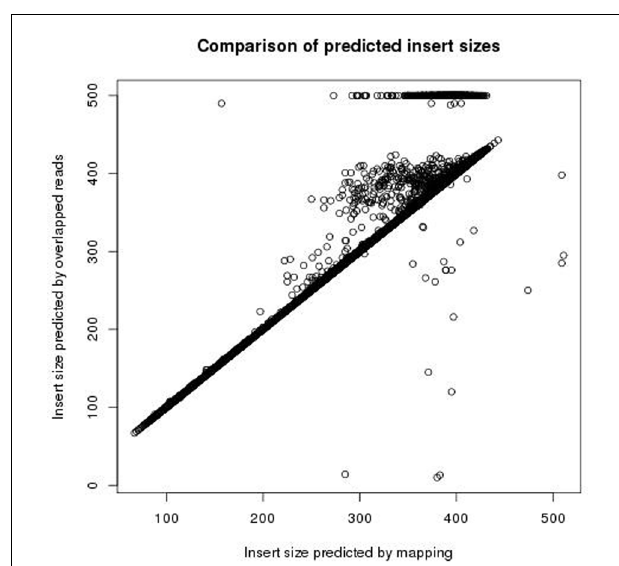
FIGURE 6 | Plot showing the insert sizes predicted using FLASH and the insert sizes predicted by mapping to the reference.